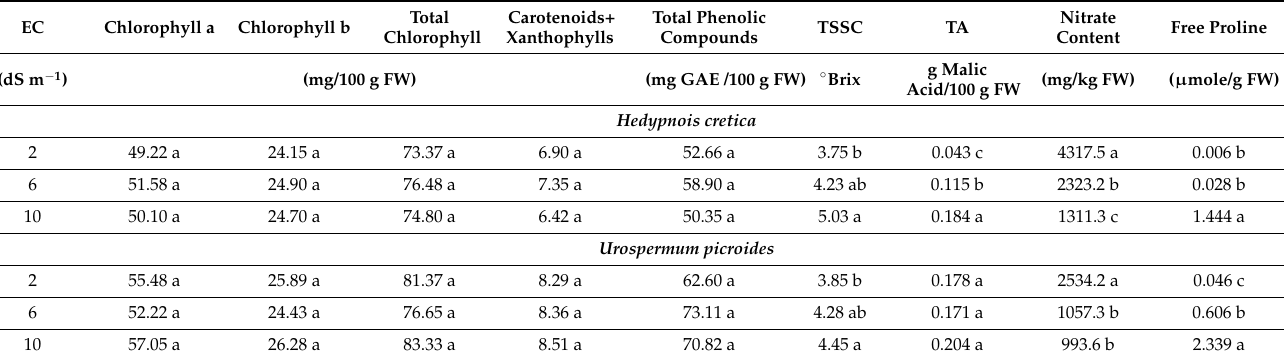
Table 5. Chlorophyll (a, b, and total; mg/100 g FW); carotenoids + xanthophylls (mg/100 g FW); total phenolics (mg GAE/100 g FW); total soluble solids content (TSSC; ◦ Brix); titratable acidity (TA; g malic acid/100 g FW); leaf nitrate content (mg/kg fw) and free proline content ( µ mole/g FW) of Hedypnois cretica and Urospermum picroides plants grown under different nutrient solution EC (2, 6, and 10 dS m − 1 )